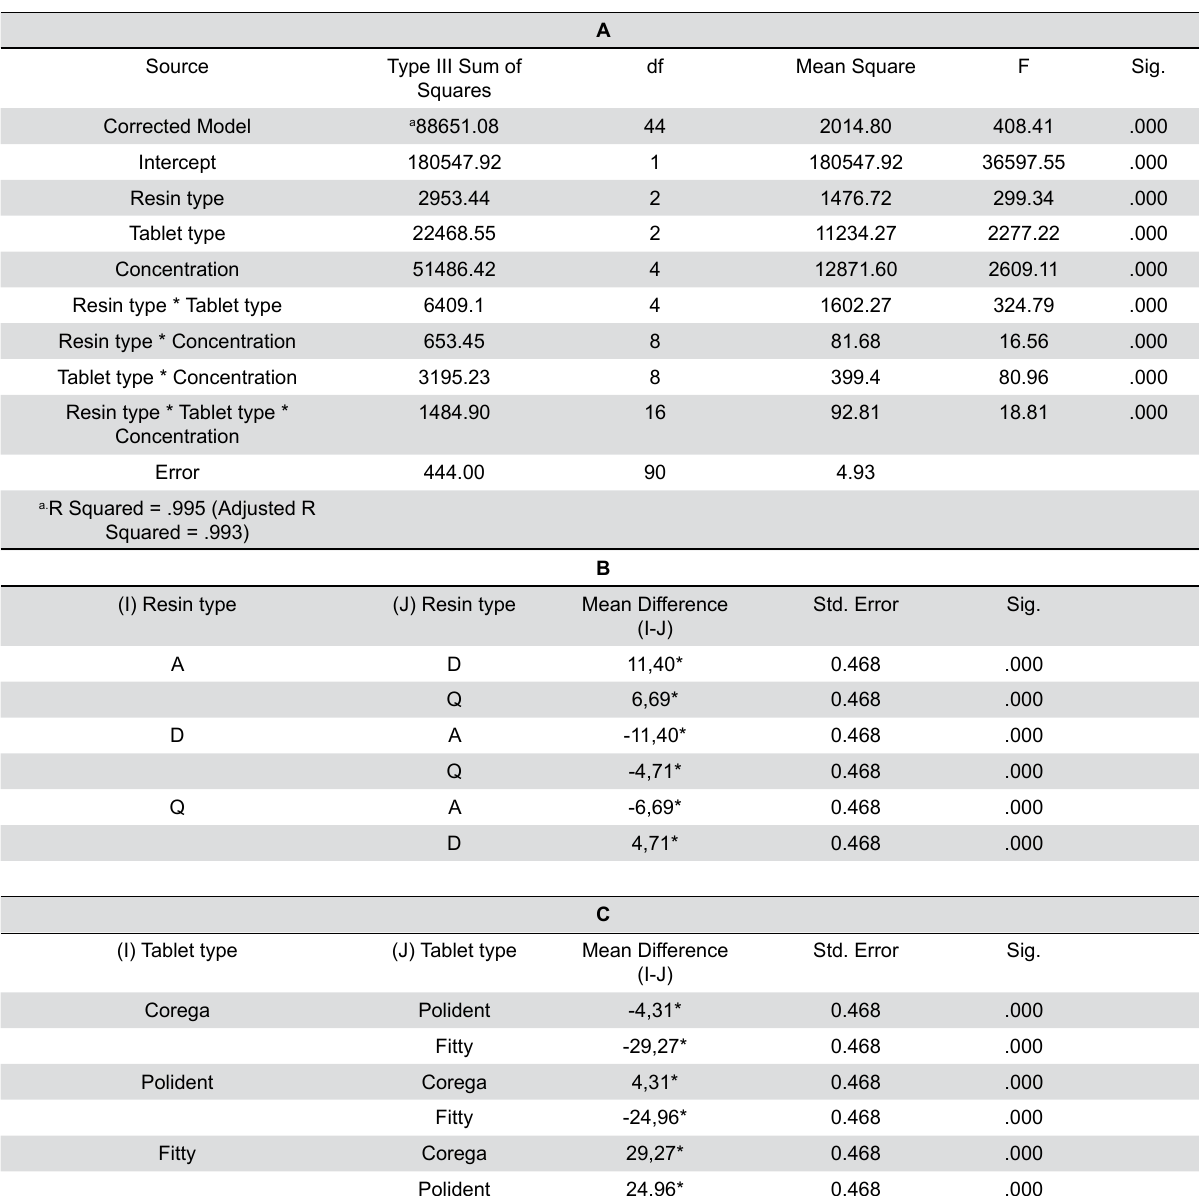
Table 2- A) Tests of Between-Subjects Effects (Dependent Variable:Viability). B) Viability&Tukey HSD for resin types. C) Viability&Tukey HSD for cleansing